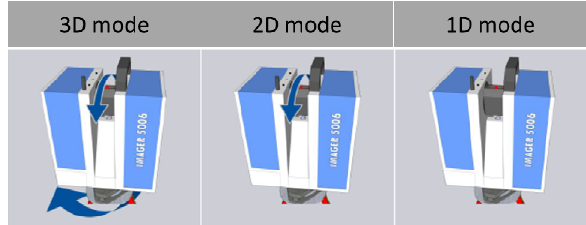
Figure 1. Operating modes of the laser scanner (Kutterer,